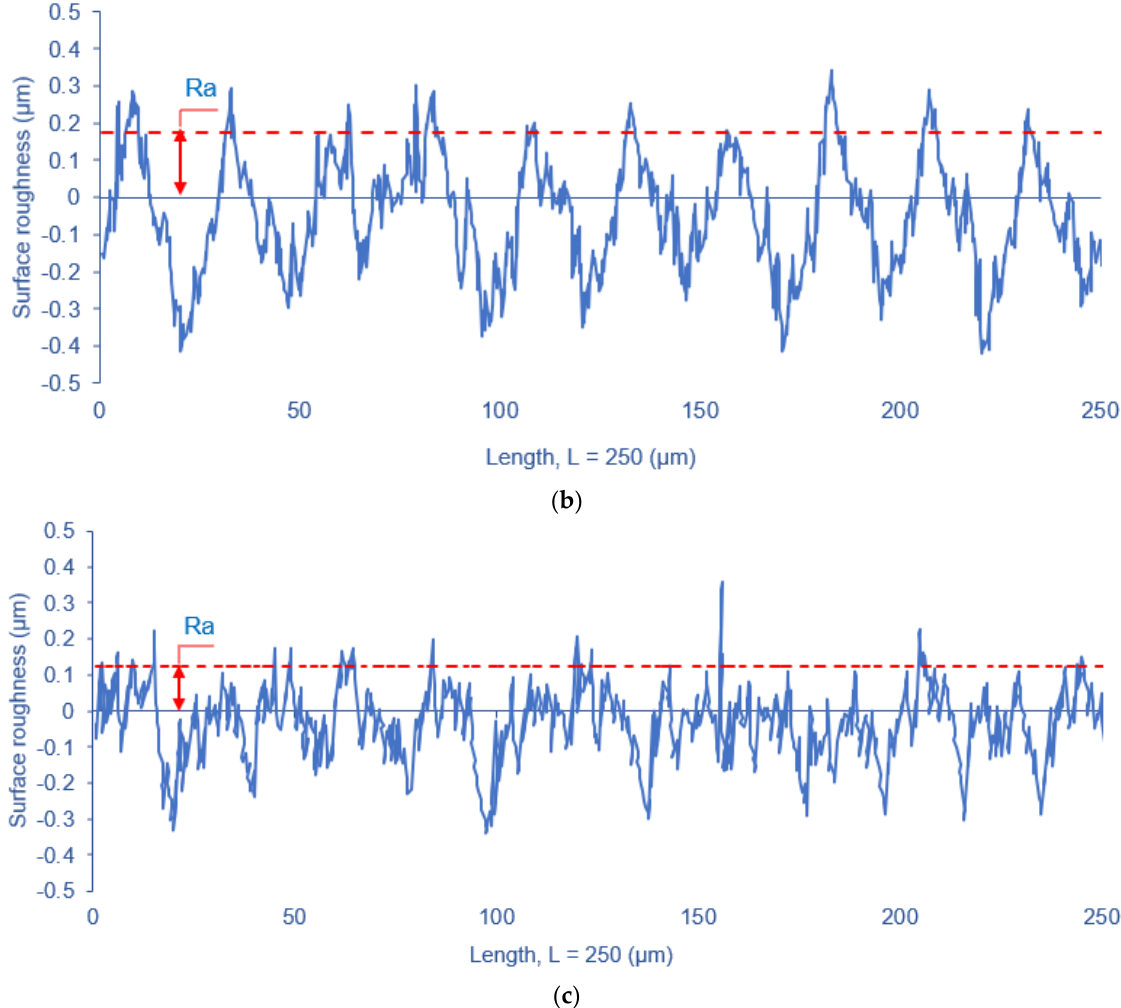
Figure 9. Measurement of Surface Roughness with Equipment and Method ( a ) and Comparison of Surface Roughness Profiles for Machining at Room Temperature ( b ) and 200 °C ( c ).